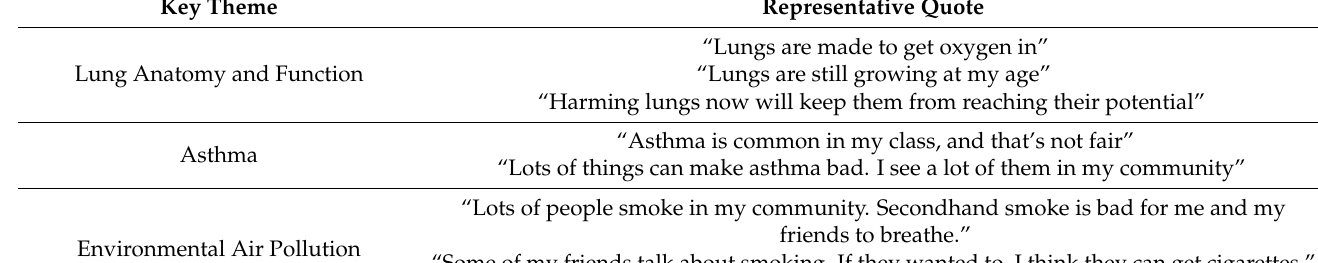
Table 3. Themes from participants of the Lung Health Ambassador Program (LHAP) as captured during individual classes. Key Theme Lung Anatomy and